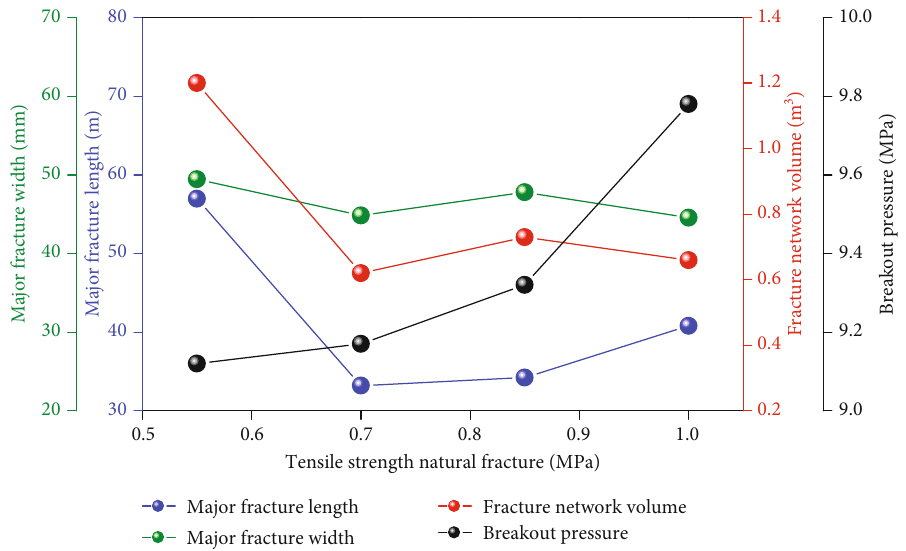
Figure 11: E ff ect of tensile strength of natural fractures on the expansion of hydraulic fractures.